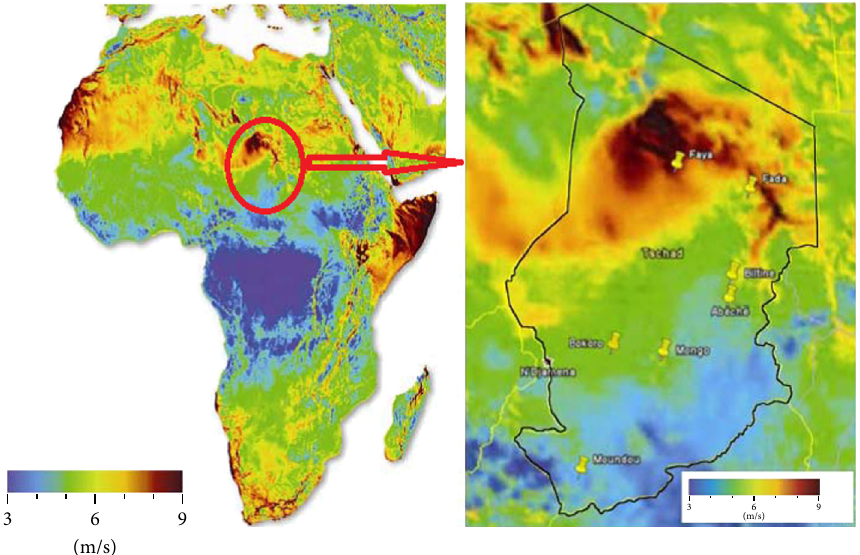
Figure 3: Wind speed pattern in